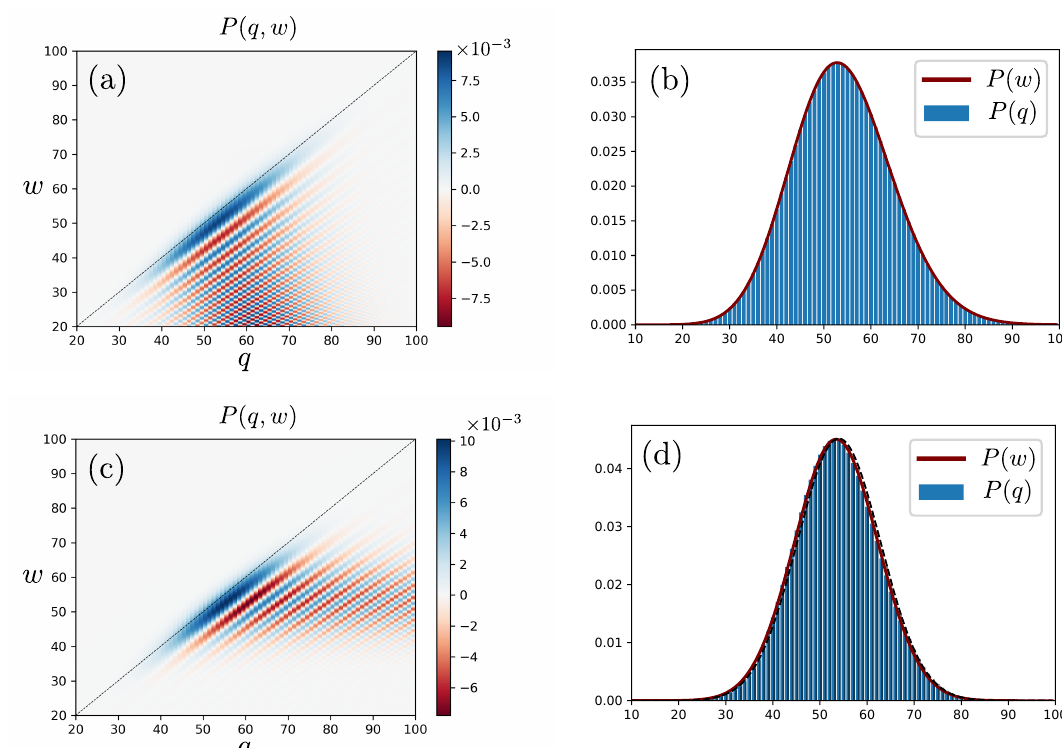
= κ . The joint distribution c h = 1, n c = 0.1, B B